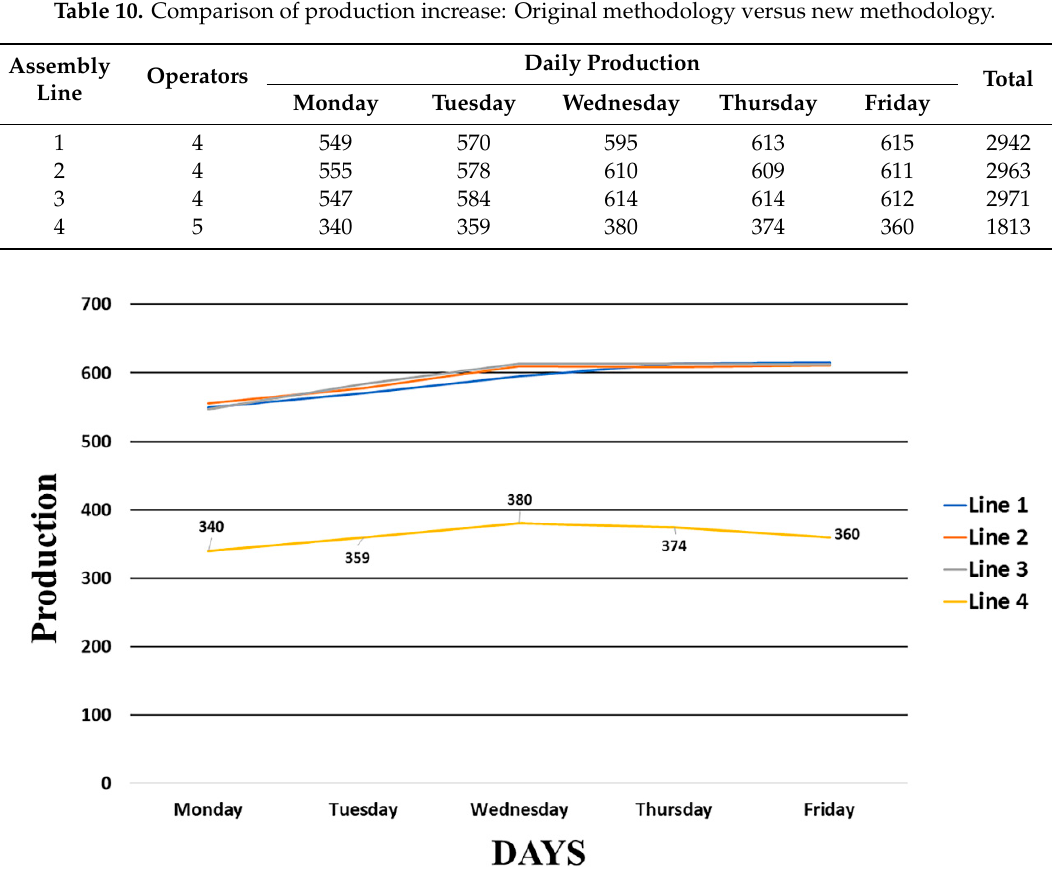
Figure 7. Comparison of production increase: Original methodology vs. new methodology.